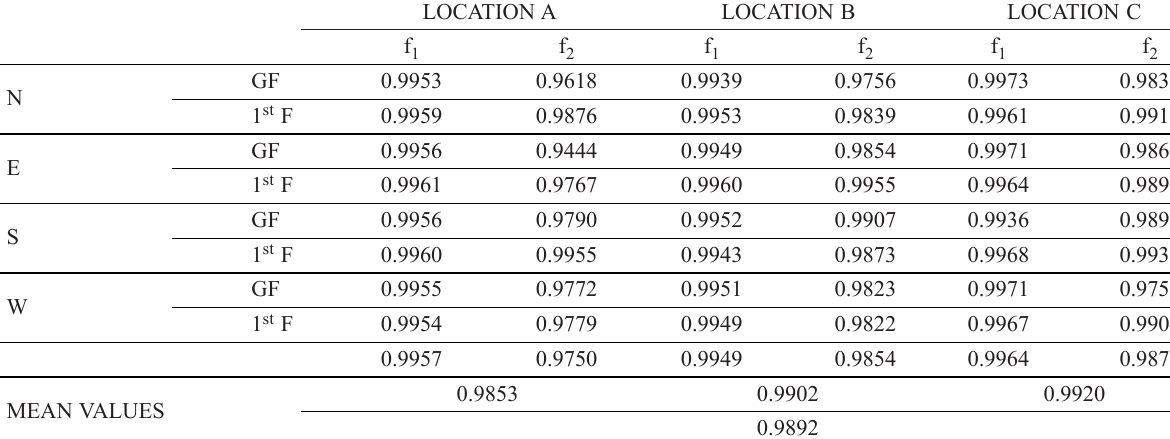
Table 3. ANN R 2 for model B